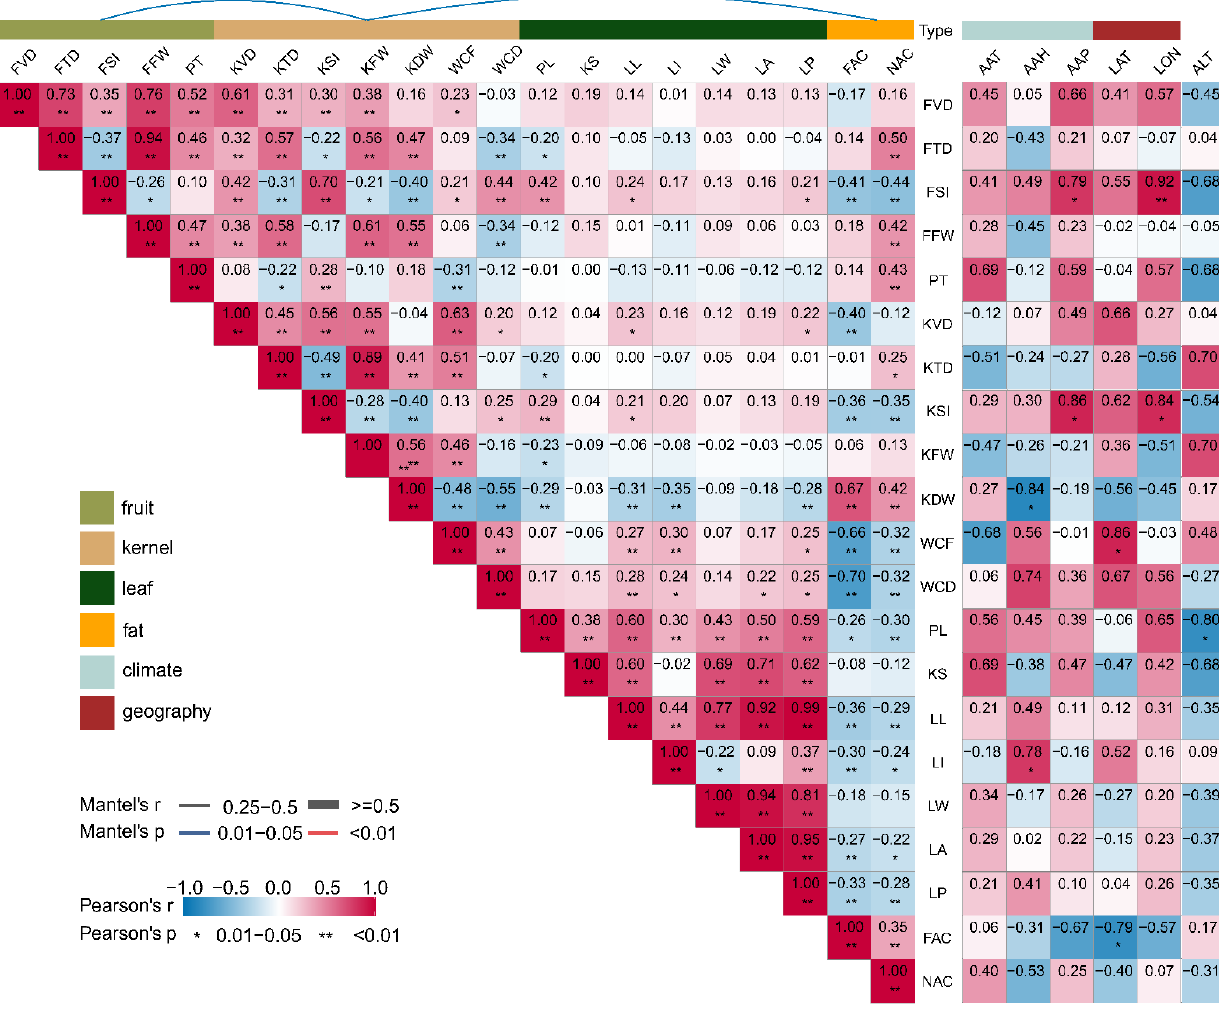
Figure 3. Correlations among the 21 traits and geoclimate factors and association between popula- tion and geographic